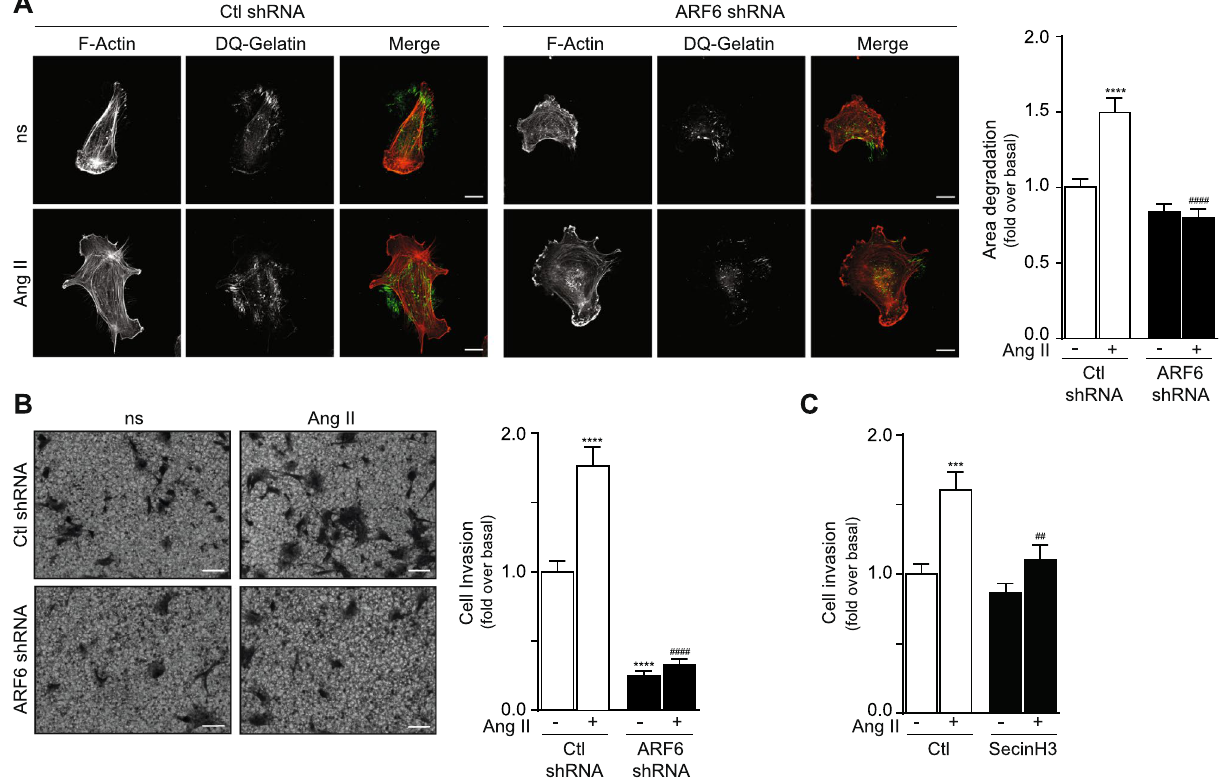
Figure 3. ARF6 modulates Ang II-mediated invasion in HASMC. ( A ) Cells were infected with a Ctl or ARF6 shRNA and seeded onto DQ gelatin for 1 h. They were stimulated with Ang II (100 nM). After 6 h, cells were fixed and actin stained using Alexa Fluor 568 phalloidin. Images are representative of the degradation area of five independent experiments with 30 cells examined per condition. Quantifications are the mean ± SEM of five independent experiments. ****P < 0.0001 comparison to the basal condition, ####P < 0.0001 compared to Ctl shRNA Ang II (Two-Way Anova) (bar = 20 µm). ( B ) 100,000 cells were infected as in ( A ) and seeded into Matrigel-coated Boyden chambers for 1 h. Afterwards cells were left untreated (non-stimulated; ns) or stimulated with Ang II (100 nM) for 24 h. Images are from the lower part of the membrane and are representative of five images taken per condition. Quantifications are the mean ± SEM of six independent experiments. ****P < 0.0001 are values compared to the basal condition, ####P < 0.0001 compared to Ctl shRNA Ang II (Two-Way Anova) (bar = 100 µm). ( C ) 100,000 cells were seeded into Matrigel-coated Boyden chambers and pretreated with DMSO (Ctl) or SecinH3 (30 µM) for 1 h. One set of cells was left untreated (non-stimulated; ns) and the other was stimulated with Ang II (100 nM) for 24 h. Quantifications are the mean ± SEM realised on five independent experiments. *** P < 0.001 are values compared to basal condition, ##P < 0.01 compared to Ctl Ang II (Two-Way